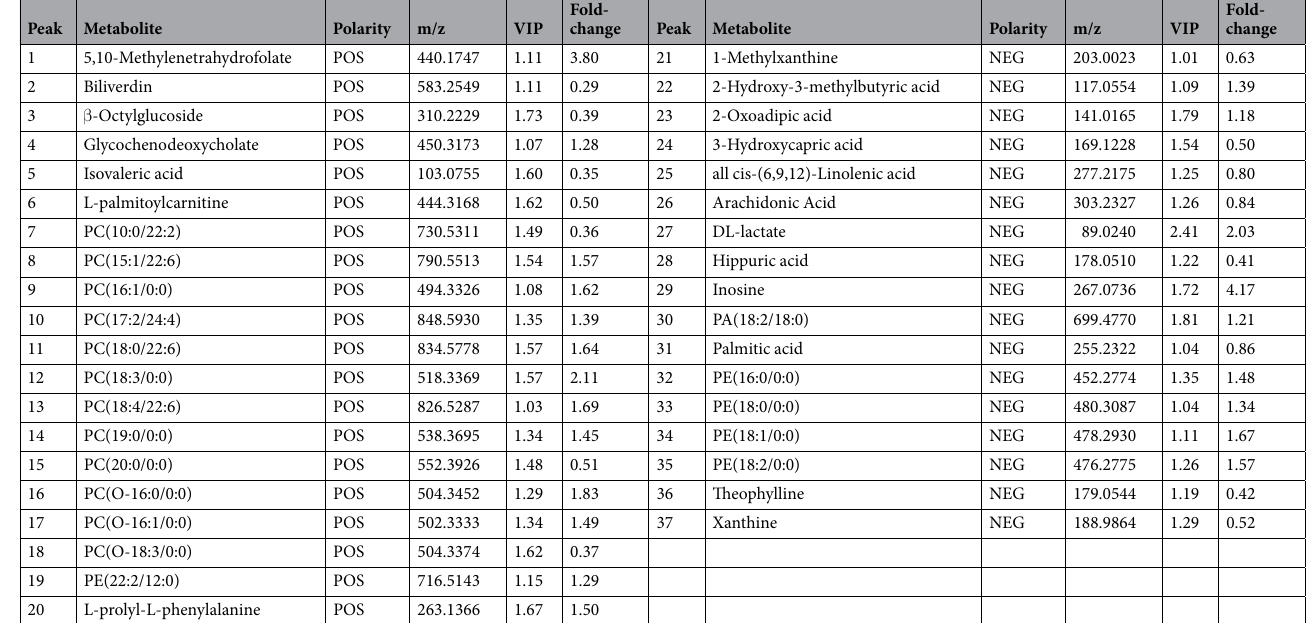
Table 2. Discrepant metabolites identified by UHPLC-Q-TOF/MS analysis between early-stage NSCLC patients and